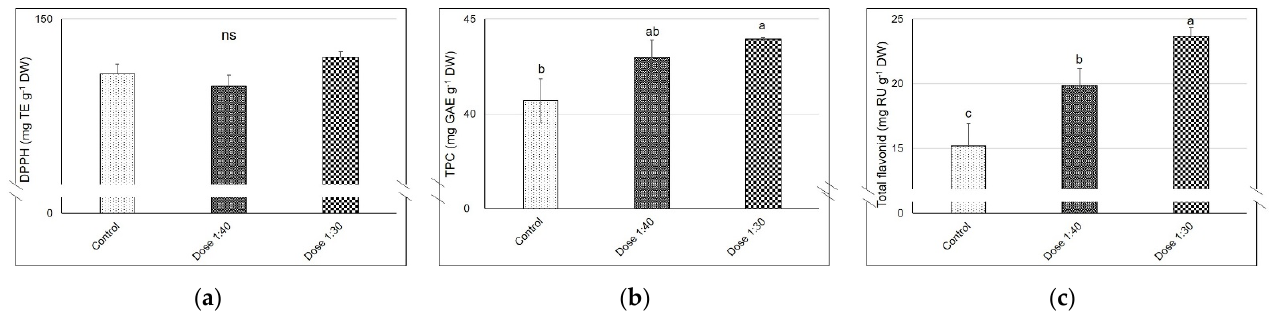
Figure 1. Effect of Moringa oleifera leaf extract (MLE) foliar application on the antioxidant activity ( a ) (DPPH, mg TE g − 1 FW), TPC ( b ) (mg GAE g − 1 FW), and total flavonoid content ( c ) (mg RU g − 1 FW) of radish baby leaf. Data are means ± standard error ( n = 3). Three biological replicates were used for the analysis. Different letters indicate significance at p < 0.05 according to Tukey’s test; ns, not significant.